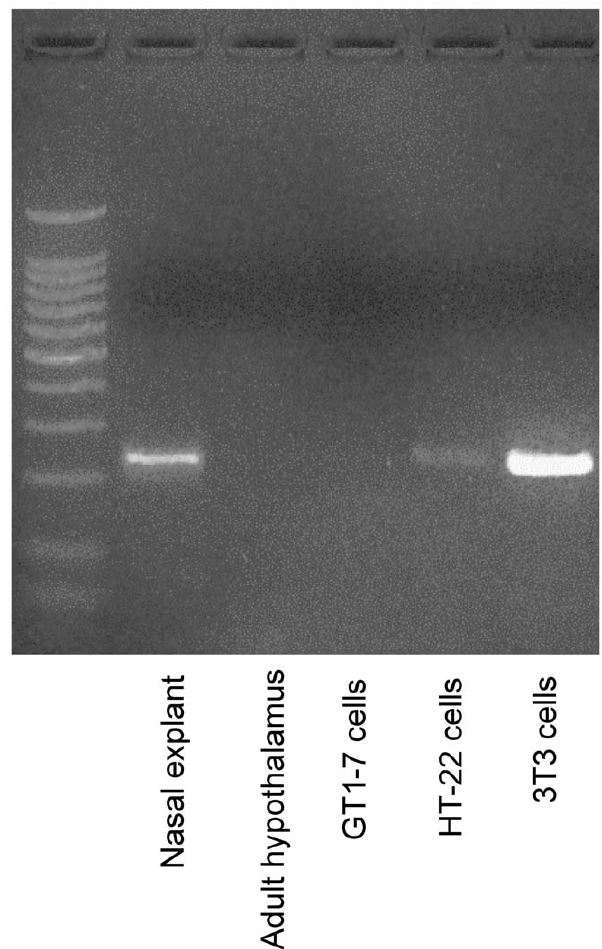
Figure 1. FGF expression in mouse brain and representative cell lines. Photomicrograph of RT-PCR product for FGF8 mRNA stained with ethidium bromide and resolved on a 2% agarose gel. Total RNA was isolated from mouse nasal explant (embryonic day 11.5; lane 2) adult hypothalamus (lane 3), hypothalamic-derived GT1-7 cells (lane 4), hippocampus-derived HT-22 cells (lane 5), and fibroblast-derived 3T3 cells (lane 6). Presence of band indicates FGF8 primary transcripts in representative tissue type or cell